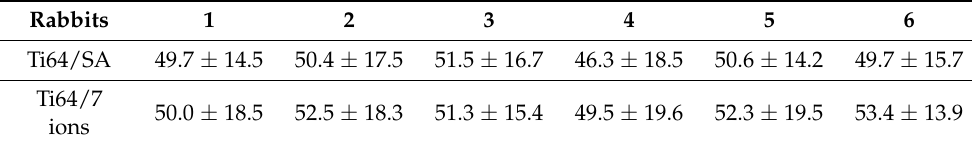
Table 3. Removal torque value measured in each animal group on Ti64/SA and Ti64/7 ion implants.